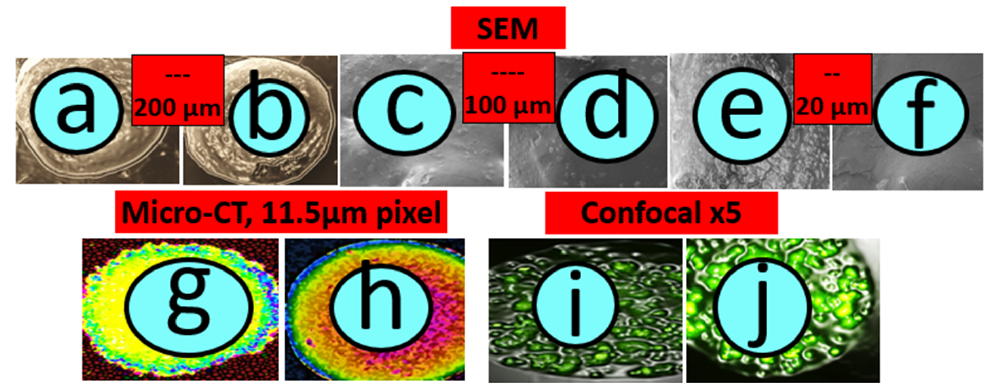
Figure 3. SEM (control: ( a , c , e ) and treatment: ( b , d , f )), micro-CT (control: ( g ) and treatment: ( h )), and confocal (control: ( i ) and treatment: ( j )) images.